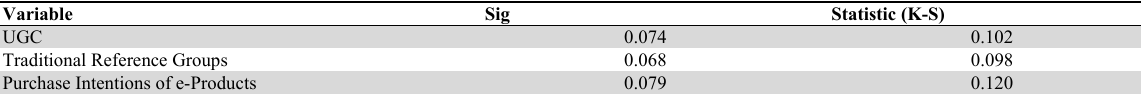
Normal distribution test results